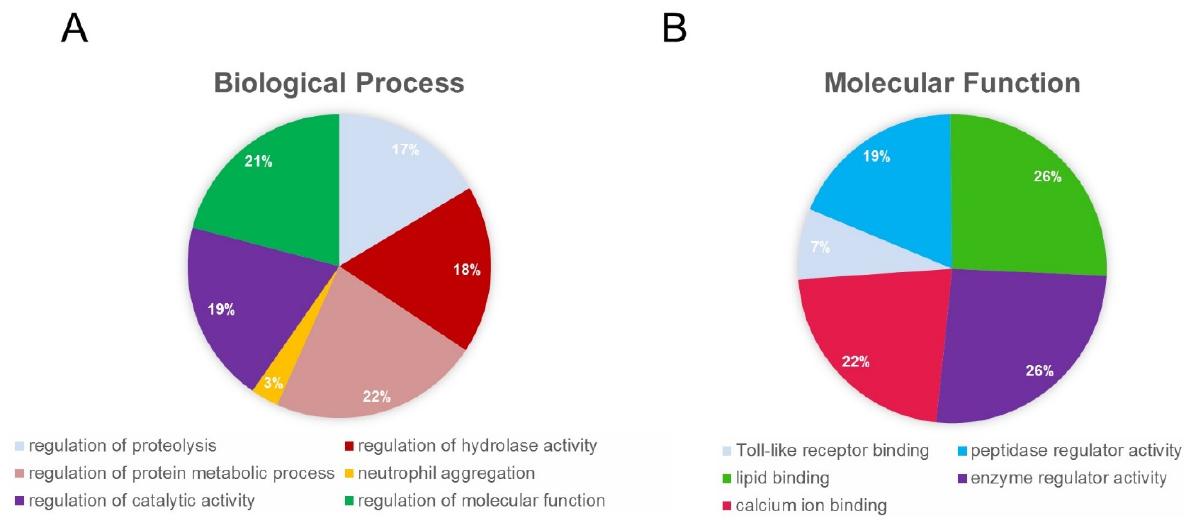
Figure 10. Gene ontology analysis of differentially expressed proteins in bladder ischemia. In this study, differentially expressed proteins with over 5-folds of changes were categorized using Gene Ontology (GO) bioinformatics tool. The GO terms with a p -value ≤ 0.05 were used to generate the pie charts. ( A ) Biological process and ( B ) molecular function. This figure is taken from our previous publication [48].